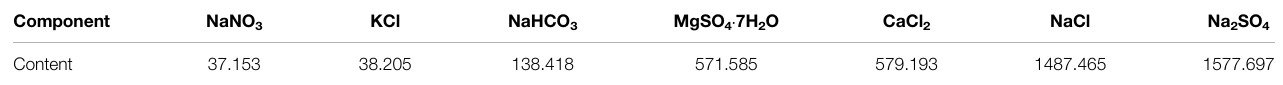
TABLE 2 | Simulated chemical components of the groundwater in the Beishan area (mg/L). Component